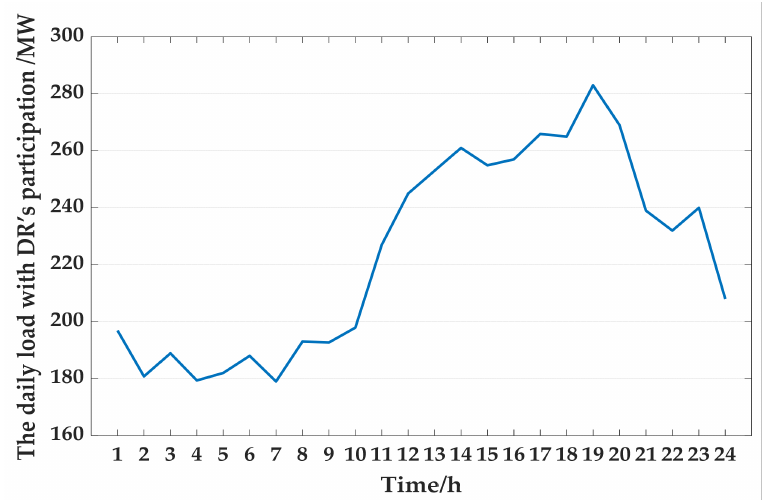
Figure 6. Daily load with DR participation in Case